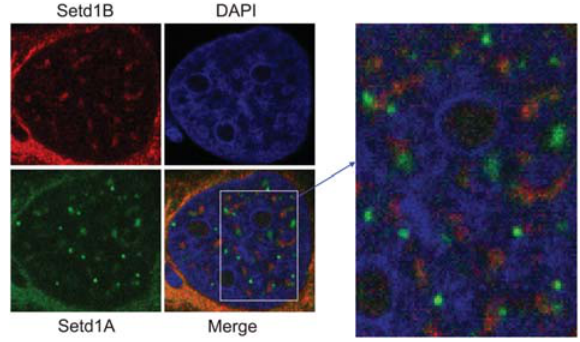
Figure 4 The Setd1A and Setd1B proteins exhibit a nearly non- overlapping subnuclear distribution. The subnuclear distribution of endogenous Setd1A (green) and Setd1B (red) proteins were detected by indirect immunofluorescence and compared with the localization of DAPI-bright heterochromatin domains (blue). An expanded view of the merged image is shown on the right, revealing that Setd1A and Setd1B reside in distinct DAPI-dim (euchromatic)